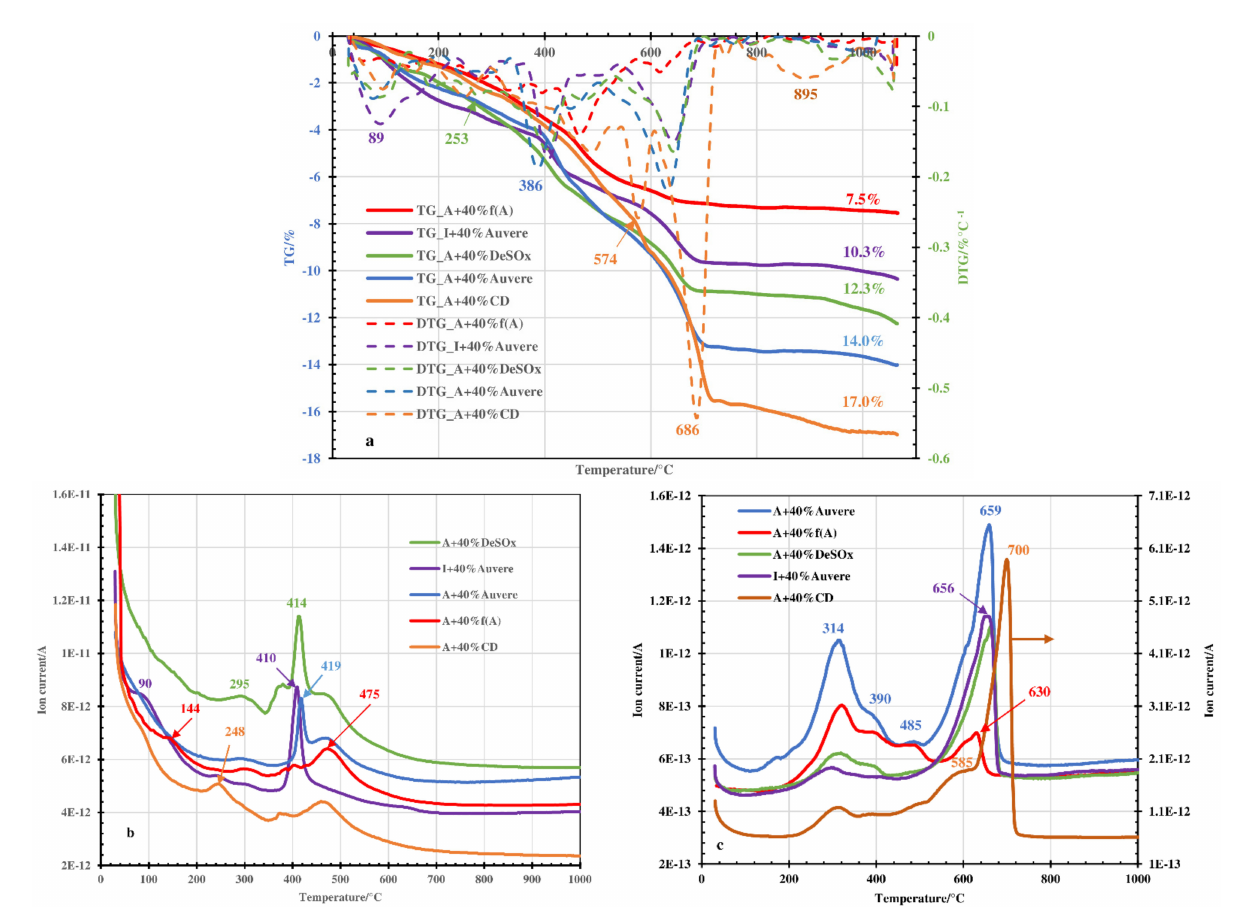
Figure 3. TG and DTG curves ( a ) and emission profiles of H 2 O ( b ) and CO 2 ( c ) upon thermal treatment of Arumetsa and illitic clay with different additives to the amount of